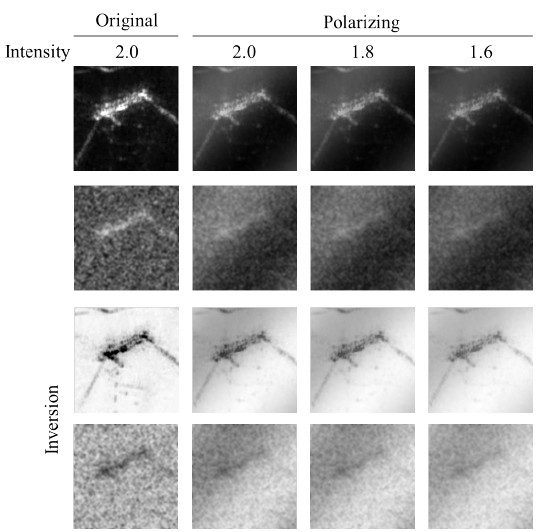
Figure 4. Images depending on whether the polarizing effect is applied or not. We implemented the noising effects on not only by spreading the noise extensively on the original CKI, but also by applying the polarizing effect.